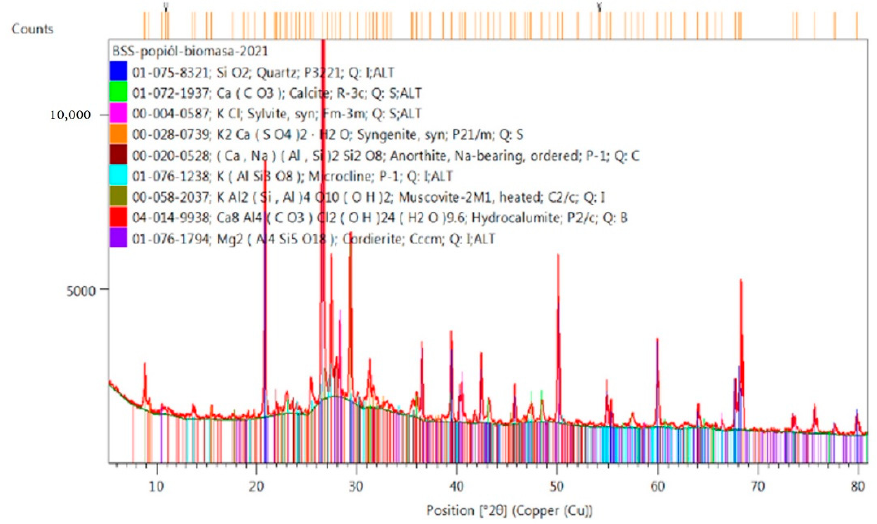
Figure 6. Phase composition of BFA.